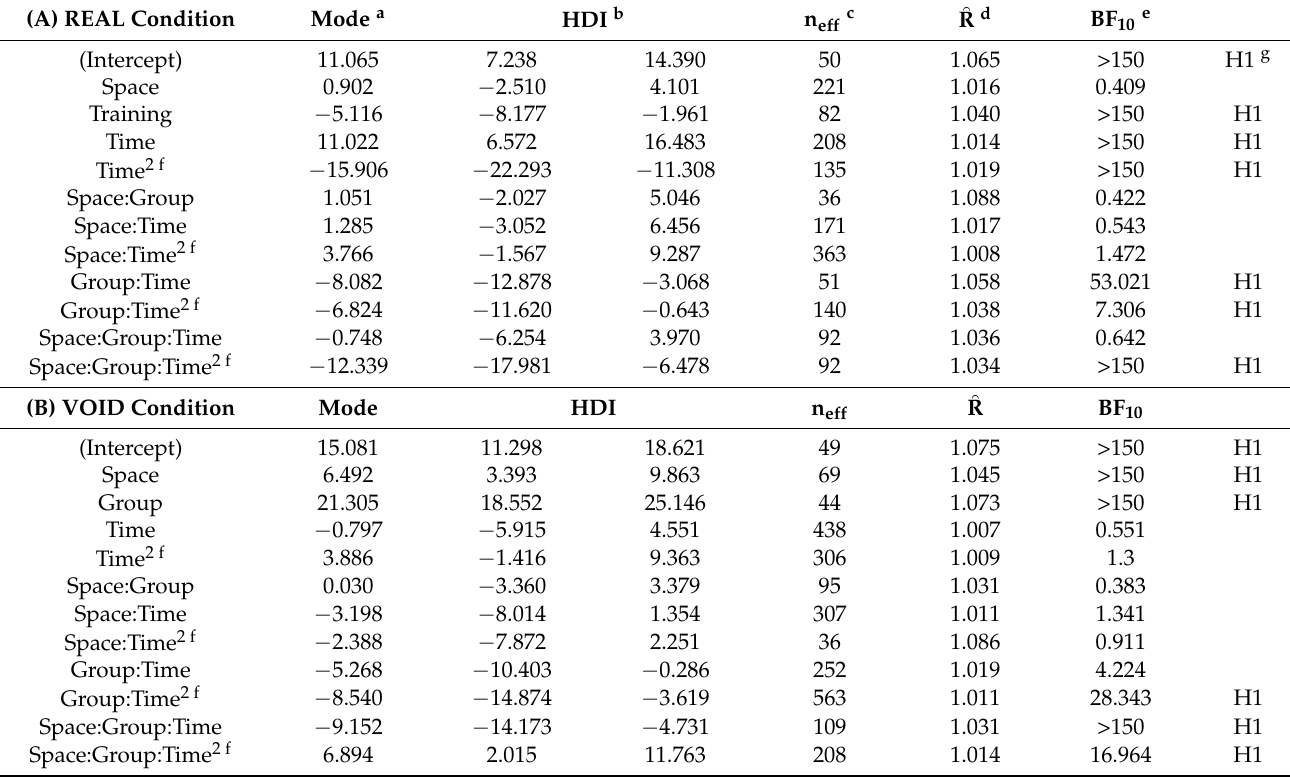
Table 2. Results for the Bayesian model for the LLCCT evaluations divided into: (A) REAL condition and (B) VOID condition. (A) REAL